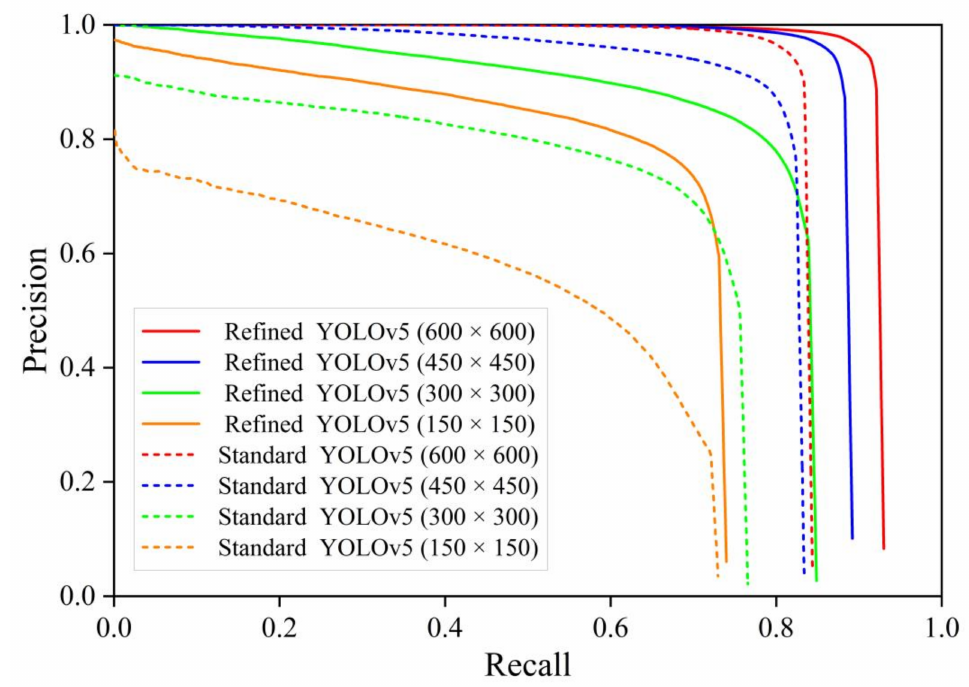
Figure 6. The precision and recall curves of wheat spike detection. Refined YOLOv5 is based on the refined network, including adding a microscale detection layer, setting prior anchor boxes, and adapting the confidence loss function of the detection layer based on the IoU (Intersection over